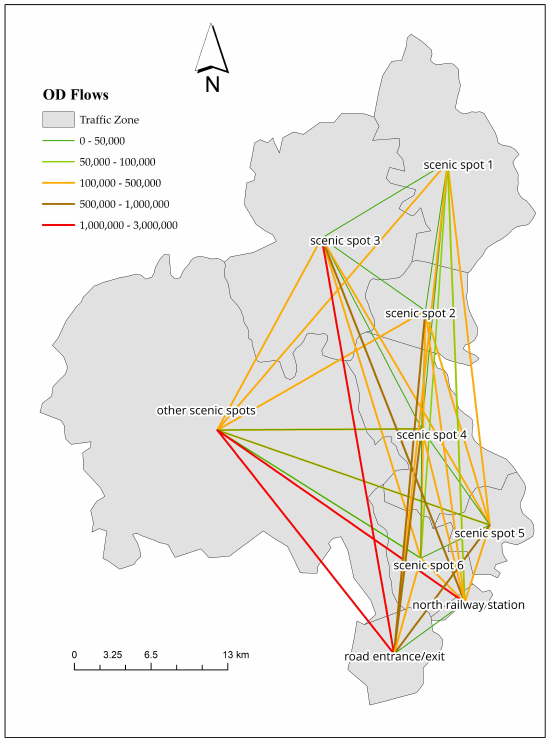
Figure 9. The origin–destination flows of expected